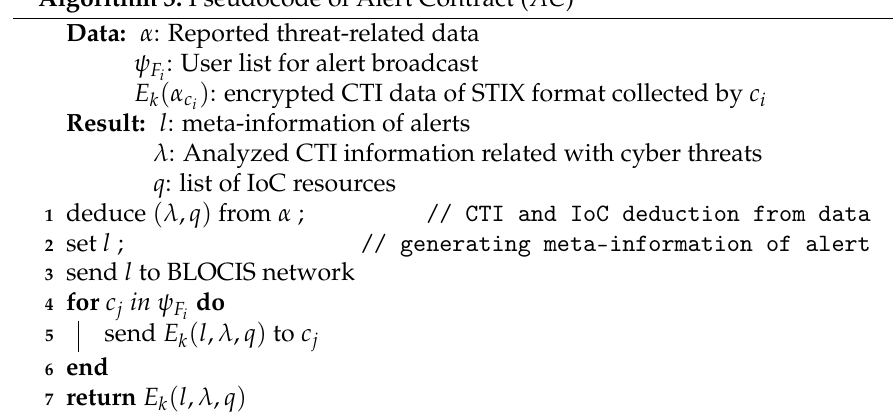
Algorithm 3: Pseudocode of Alert Contract ( AC